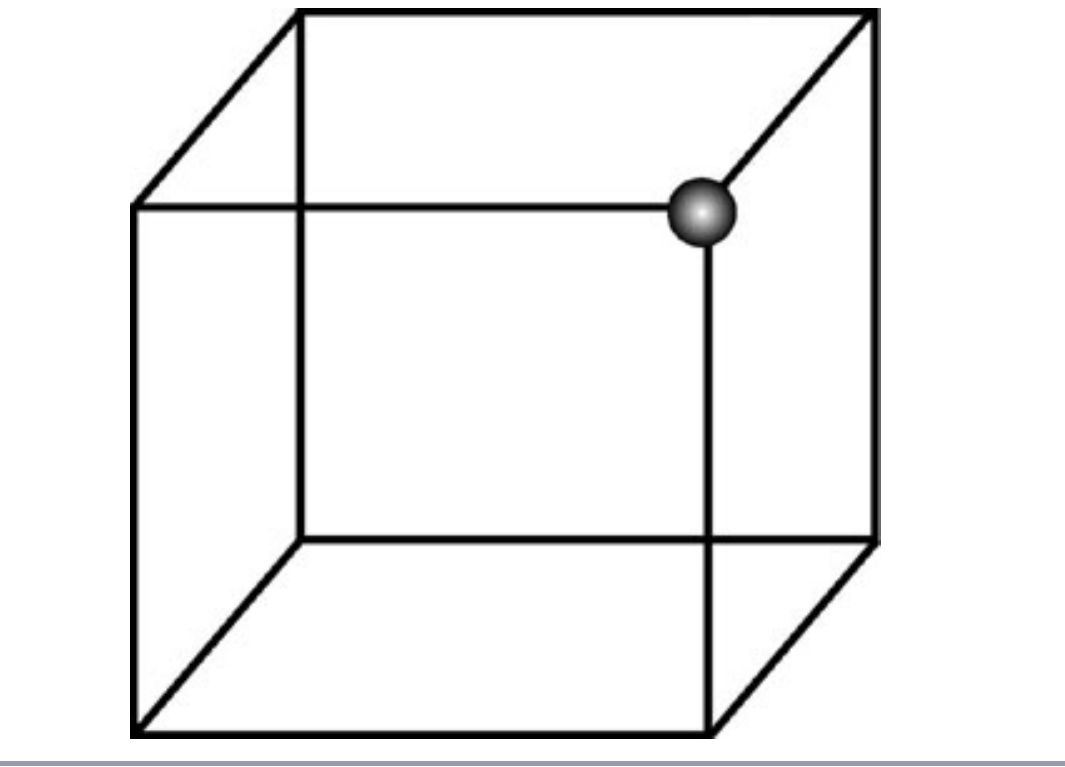
Fig. 3. Interpretation of images is notoriously ambiguous. You can imagine the marked corner in the Necker cube to be at the front side or at the back side. Once you see one interpretation, shifting to the other one is not